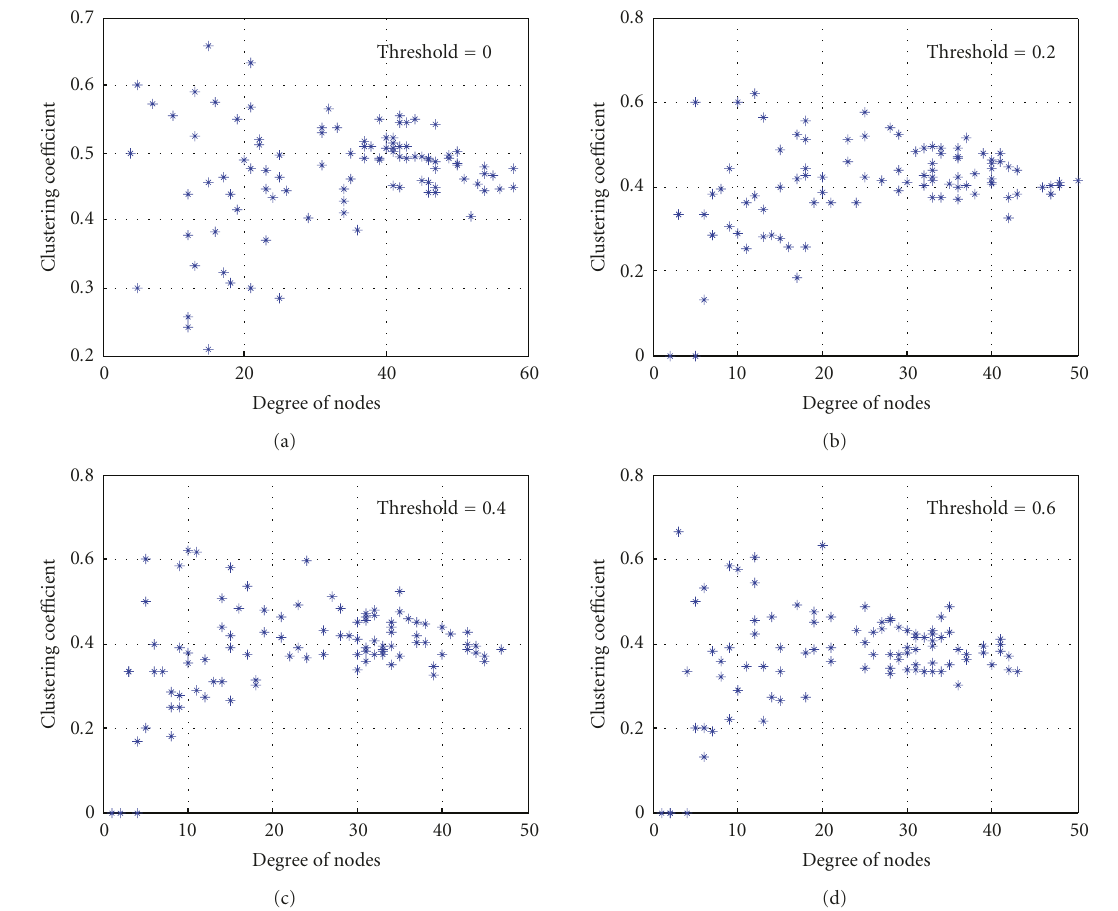
Figure 14: Variation of clustering coe ffi cient with degree of nodes: dataset